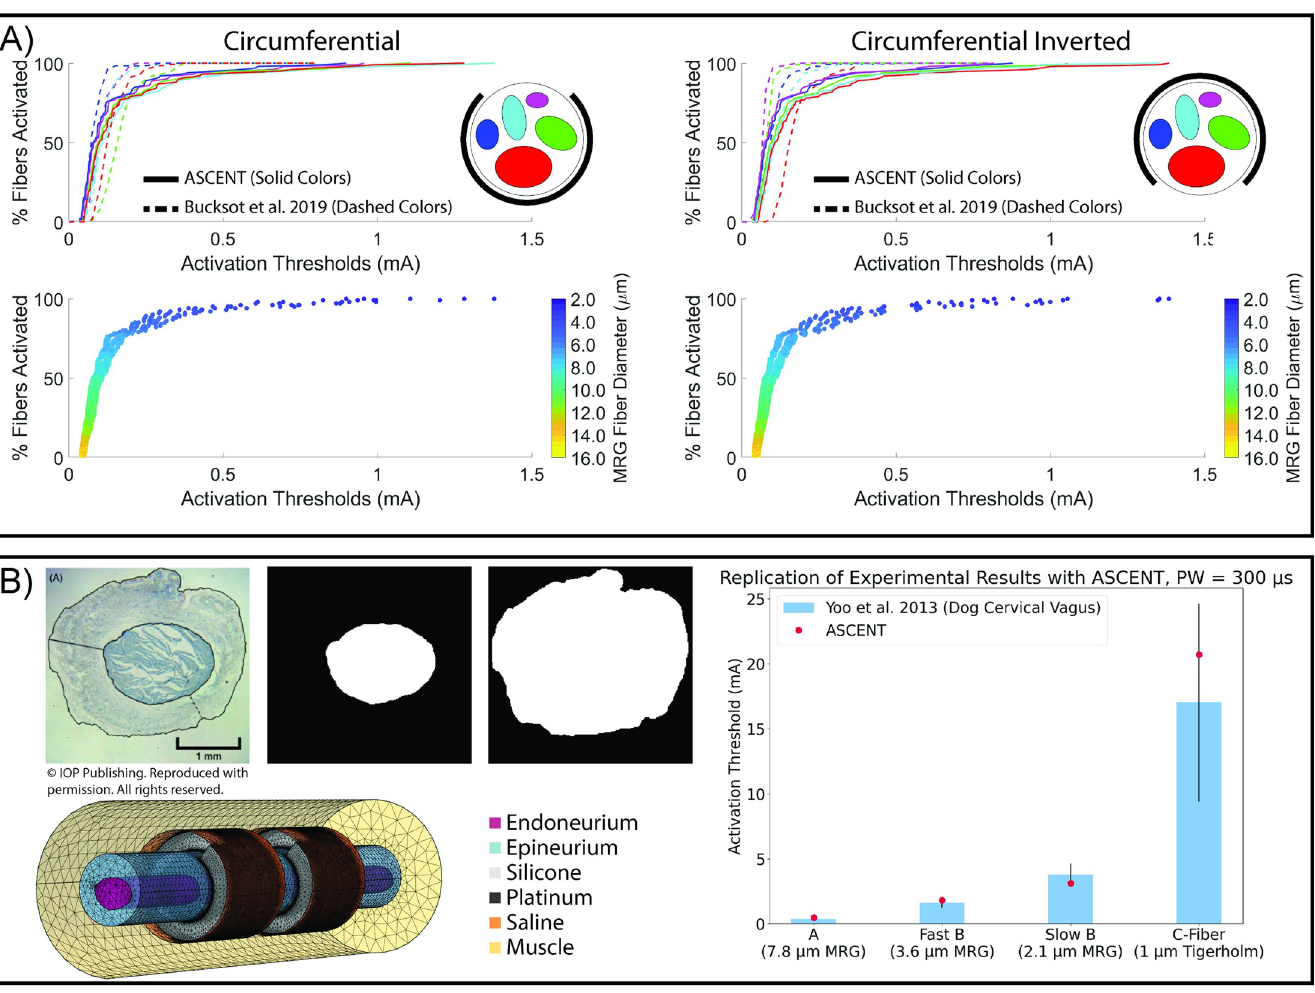
Fig 5. Using ASCENT to replicate previously published computational models and to model an in vivo experiment. (A) Recruitment curve for each fascicle in a model of the rabbit sciatic nerve for two rotations of a bipolar cuff electrode [11]. Fiber thresholds are in response to a 100 μ s per phase biphasic rectangular pulse (i.e., BIPHASIC_PULSE_TRAIN). We simulated mammalian myelinated fibers at 0.5 μ m diameter increments from 2 to 16 μ m (i.e., MRG_INTERPOLATION) with 10 fibers of each diameter at consistent locations in each fascicle (i.e., UNIFORM_COUNT). We generated fiber recruitment curves by defining a population of fiber diameters from a normal distribution (8.85 ± 3.1 μ m, 100 fibers per fascicle) and rounded each fiber diameter to the nearest 0.5 μ m to draw from our modeled activation thresholds randomly. Configuration and input files used to replicate the results are provided in examples/results/bucksot_2019/. (B) Using ASCENT to model electrophysiology study of dog vagus stimulation [40]. We used Photoshop (Adobe Inc., San Jose, CA) to segment a micrograph from one of the animals in the original publication. We placed the nerve in a 2 mm diameter LivaNova helical cuff electrode delivering a 300 μ s monophasic rectangular pulse (i.e., MONOPHASIC_PULSE_TRAIN), as used experimentally. We computed activation thresholds for myelinated (i.e., MRG_INTERPOLATION: 2.1, 3.6, and 7.8 μ m diameter) and unmyelinated (i.e., TIGERHOLM: 1.0 μ m diameter) fiber models, corresponding to the fiber types reported in the original study. We report the modeled threshold of a single fiber of each type at the centroid of the fascicle (i.e., CENTROID) (red dot) overlaid on the in vivo ENG thresholds (blue bars with black error bars: mean ± SD) of both myelinated (n = 5 dogs) and unmyelinated (n = 4 dogs) vagus nerve fibers. Our prior modeling studies show that fibers of a consistent diameter placed in the same fascicle have nearly identical thresholds [10]. Configuration and input files used to model the experiment are provided in examples/results/yoo_2013/